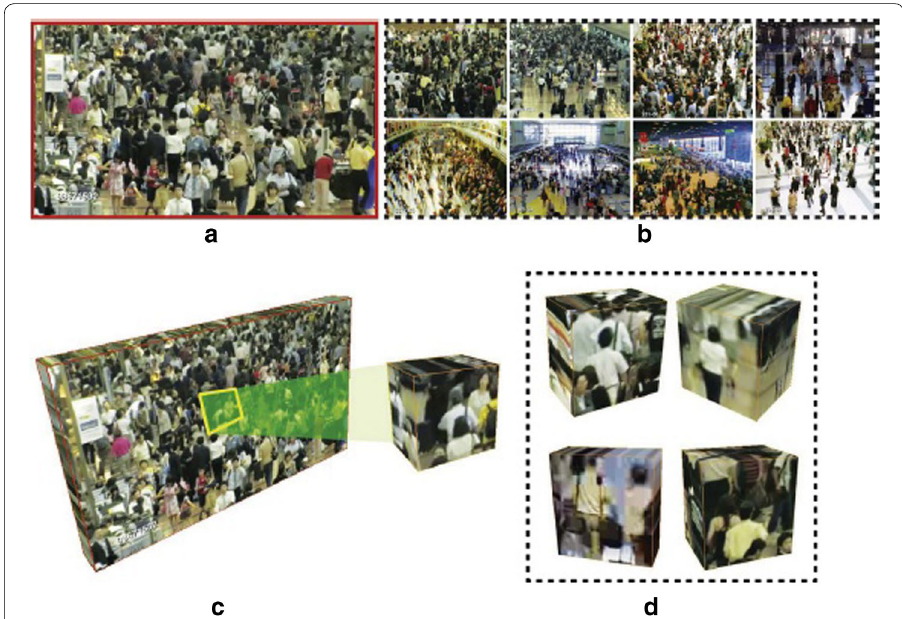
Fig. 2 a Test video, b results of global matching, c a query crowd patch, d matching crowd patches